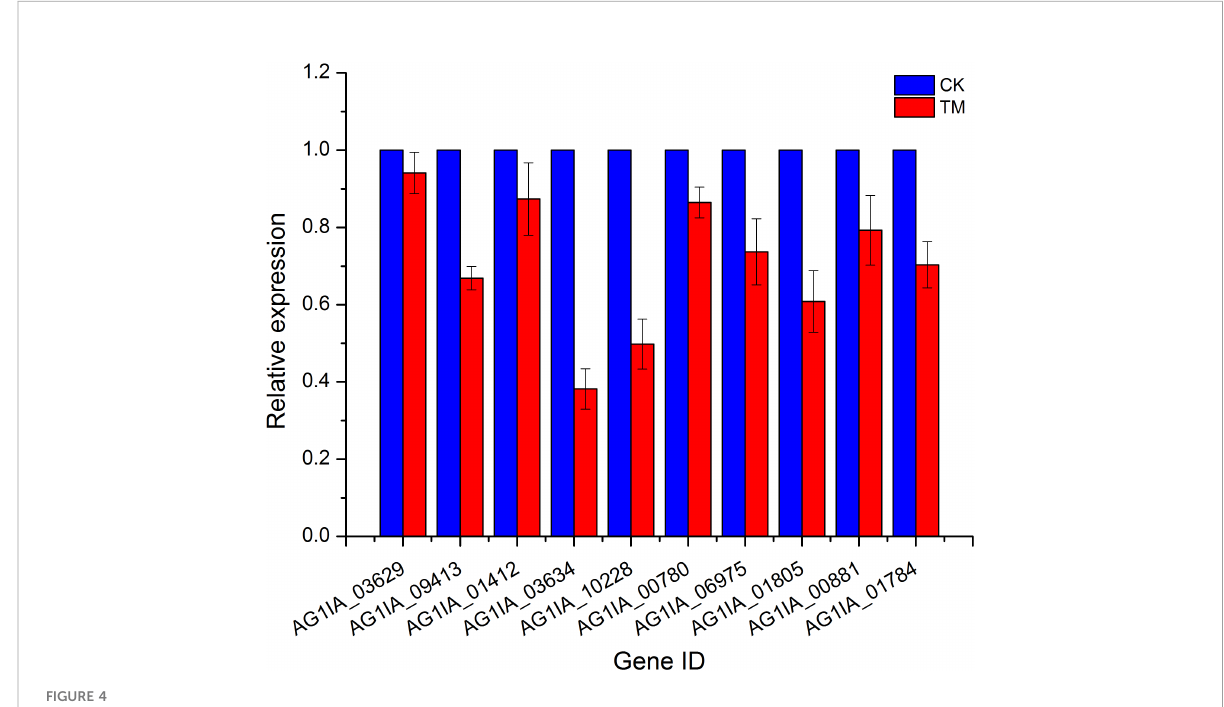
FIGURE 4 qRT-PCR validation of PCN-related